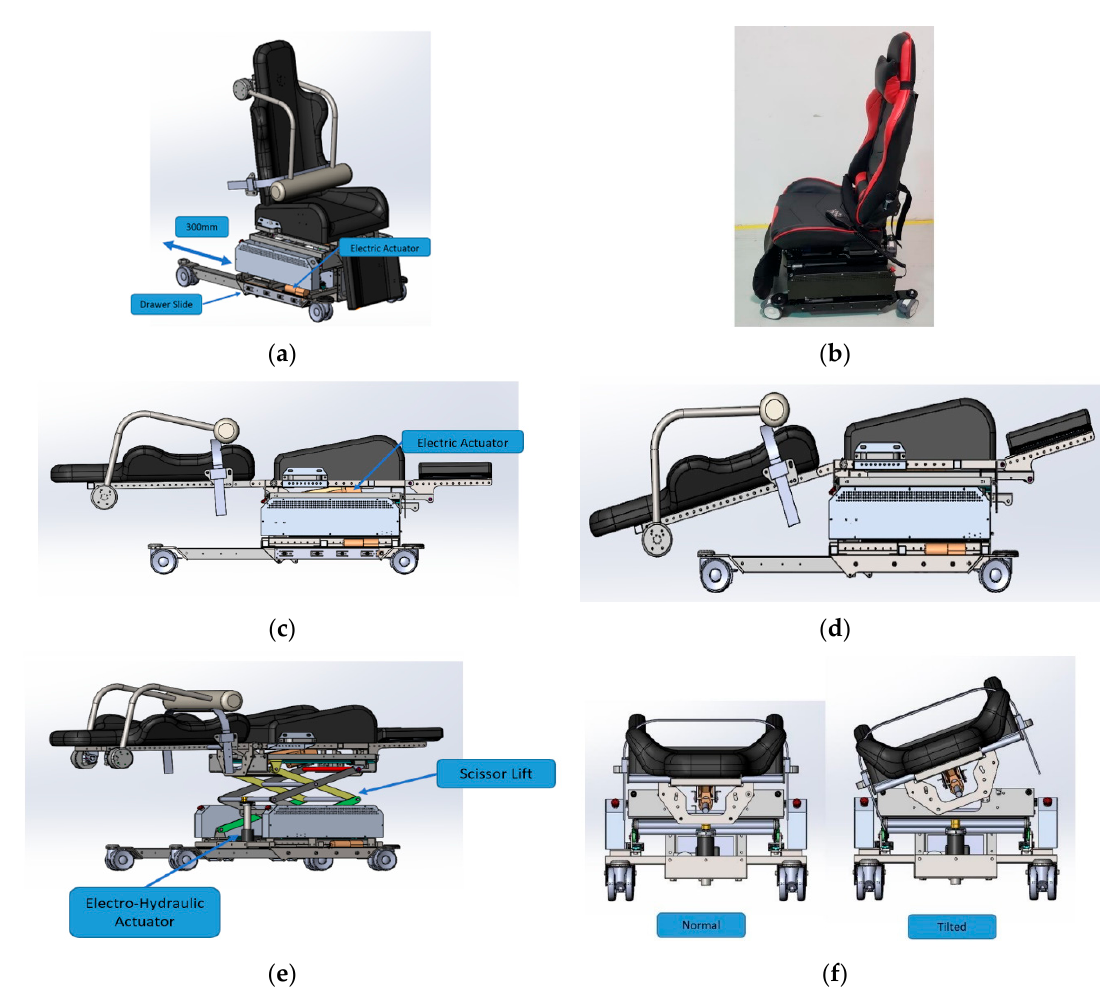
Figure 4. Multi-position of IMOVE-II. ( a ) Resting sitting position. ( b ) Photo on right without restraint module. ( c ) Supine position. ( d ) Trendelenburg position. ( e ) Height adjustment. ( f ) Lateral tilt position.